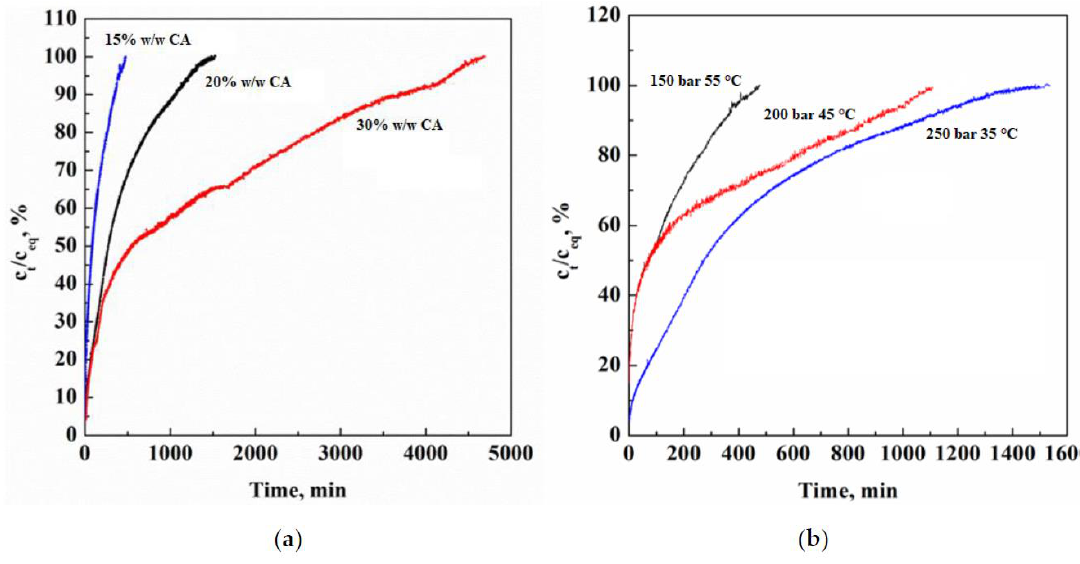
Figure 6. Ag release curves from CA membranes: ( a ) at different CA concentrations; ( b ) produced at different process operative conditions.